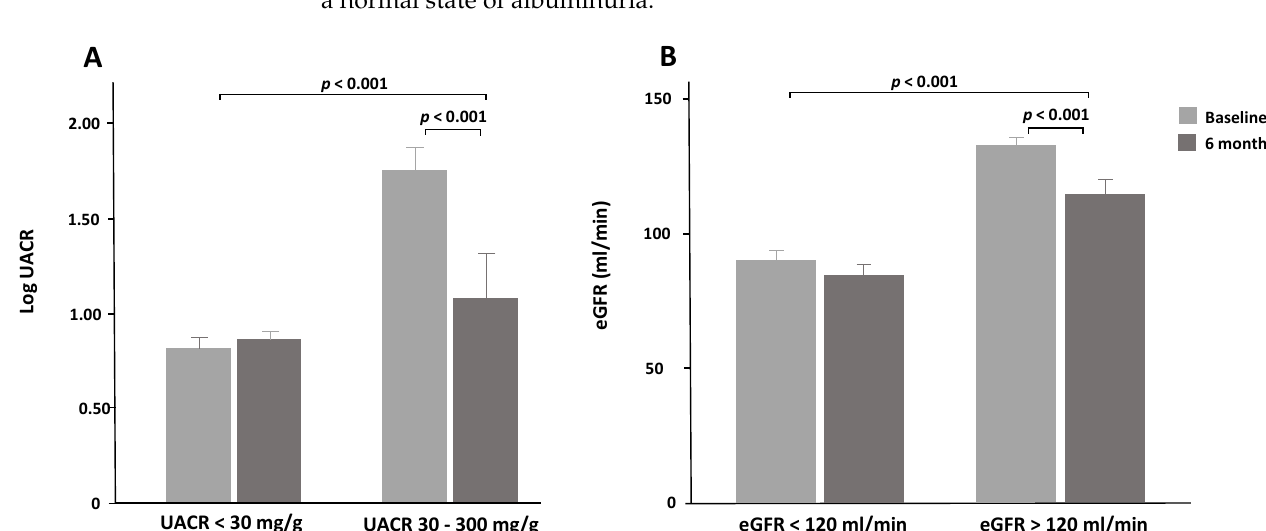
Figure 1. ( A ): Changes in urinary albumin-to-creatine ratio (UACR) between baseline and 6 months according to UACR baseline status. ( B ): Changes in estimated glomerular filtration rate (eGFR) between baseline and 6 months according to eGFR baseline status.